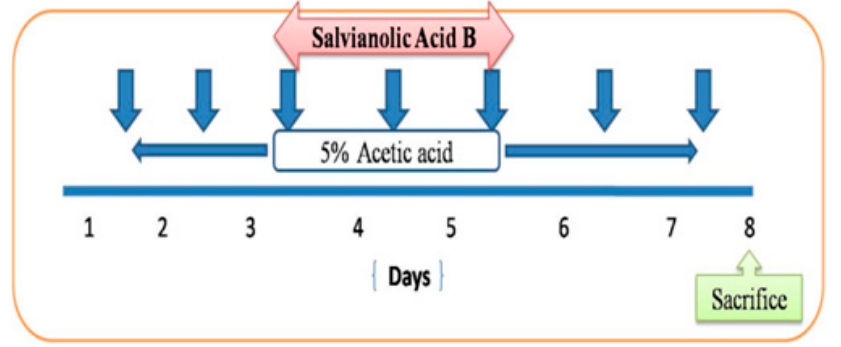
Figure 2. Experimental design. Mice in the AA and Sal B group received an intrarectal dose of 1 mL of 5% AA, whereas the normal control group animals were given 1 mL of sterile saline. On day 8 blood and colonic tissues were collected.